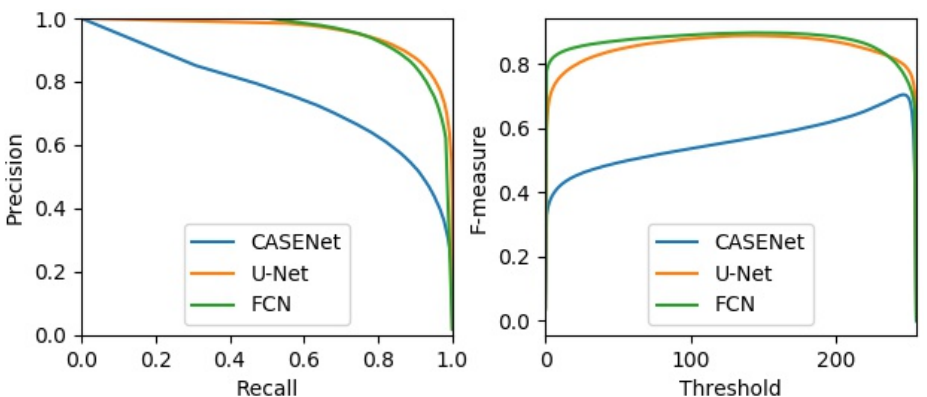
Figure 14. Comparison of precision-recall curves and F-measure curves of different methods.